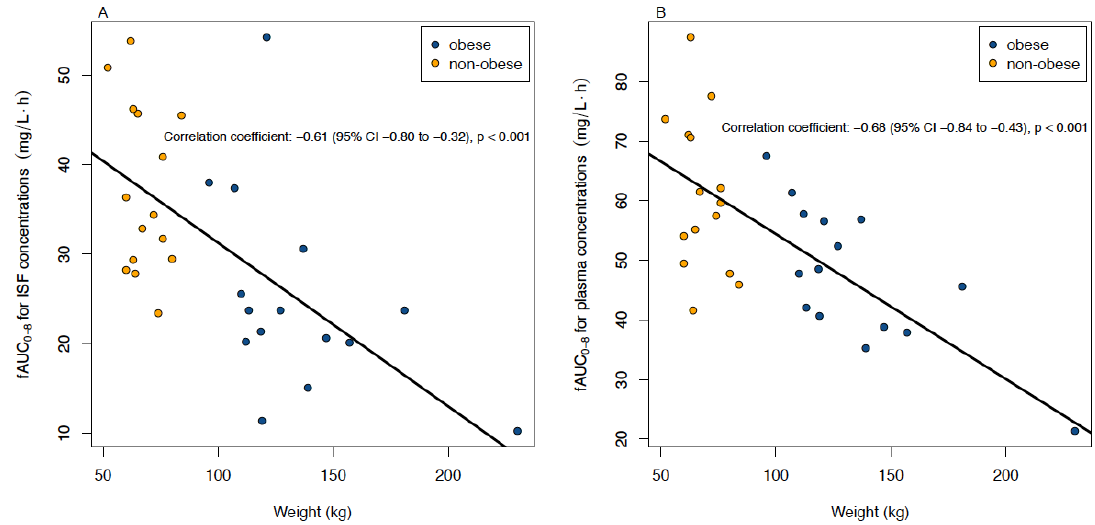
Figure 2. Correlation between the area under the concentration–time curve for unbound linezolid ( f AUC 0–8 ) ( A ) in the interstitial fluid of subcutaneous adipose tissue (ISF) and ( B ) in plasma and weight after single intravenous administration of 600 mg linezolid. f AUC = area under the concentration–time curve of unbound concentrations; CI = confidence